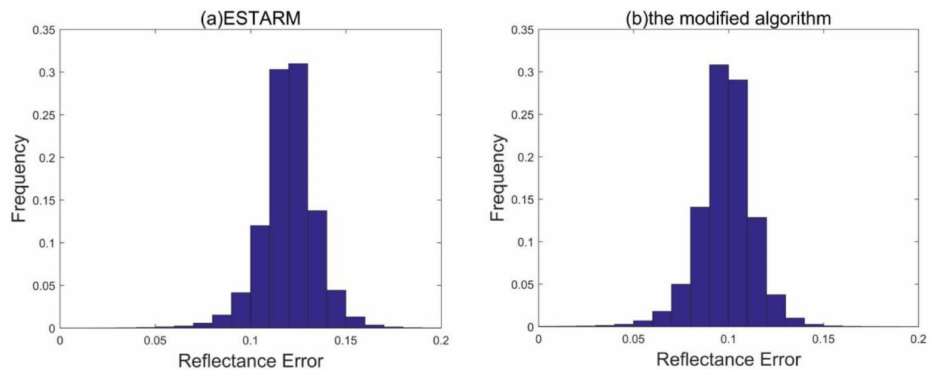
Figure 10. Frequency statistics histogram of the R mean absolute di ff erence of results predicted by ESTARFM ( a ) and the modified algorithm ( b ) in results of Langfang.